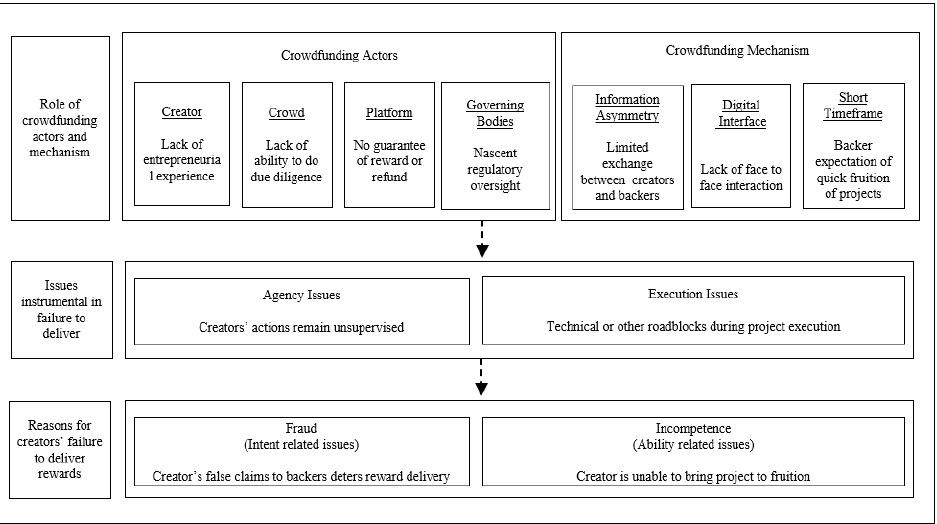
Figure 1. An overview of factors that contribute to creators’ failure to deliver rewards to backers in rewards-based crowdfunding.